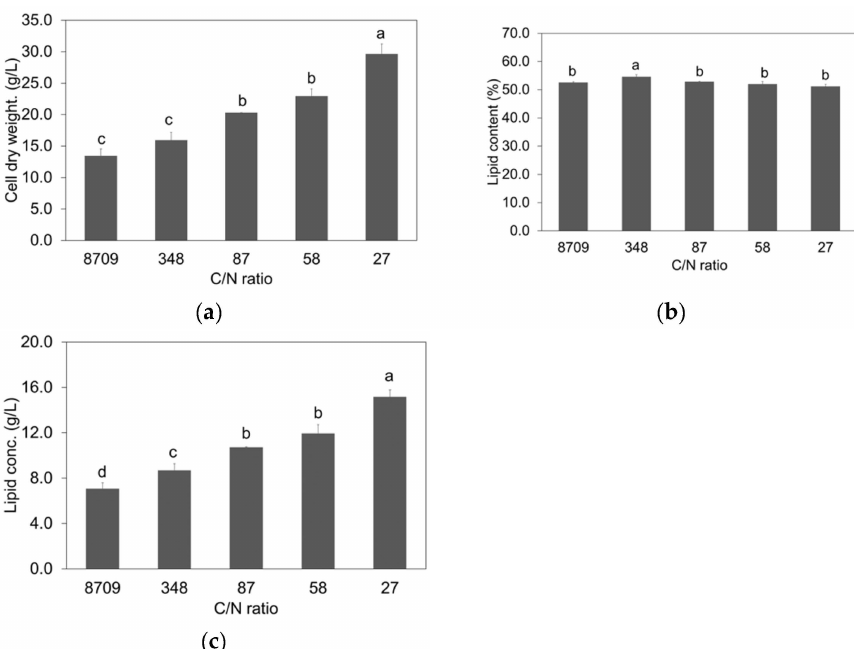
Figure 4. Cell dry weight ( a ), lipid content ( b ), and lipid concentration ( c ) when culturing R. glutinis TISTR 5159 in bagasse hydrolysate with different C/N molar ratios obtained by adding yeast extract. Different letters above the bars indicated significant differences in mean values at 95% confidence